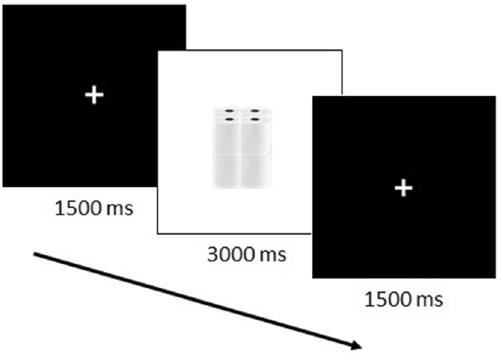
Figure 2. Experimental design for decision task in Experiment 1 and